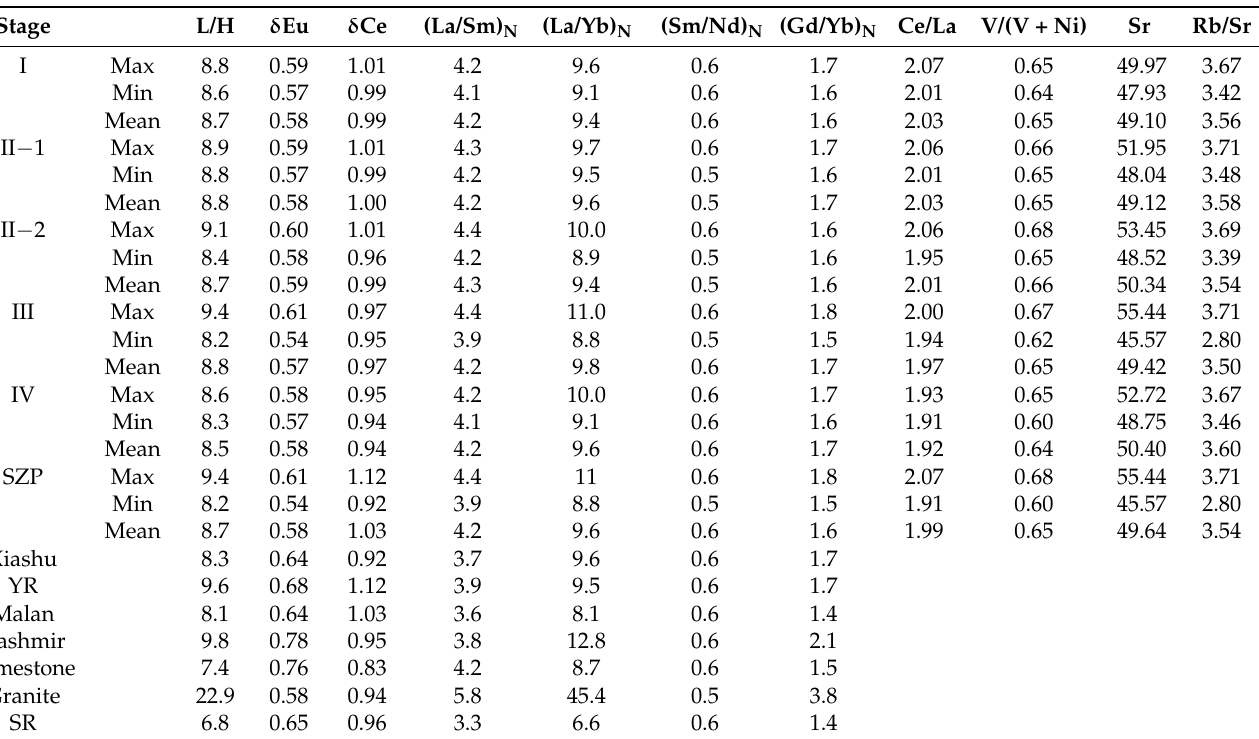
Table 4. Parameter characteristics of REEs and element ratios as Paleo − redox proxies, and Paleocli- mate proxies in the SZP profile (The unit of Sr is mg · kg − 1